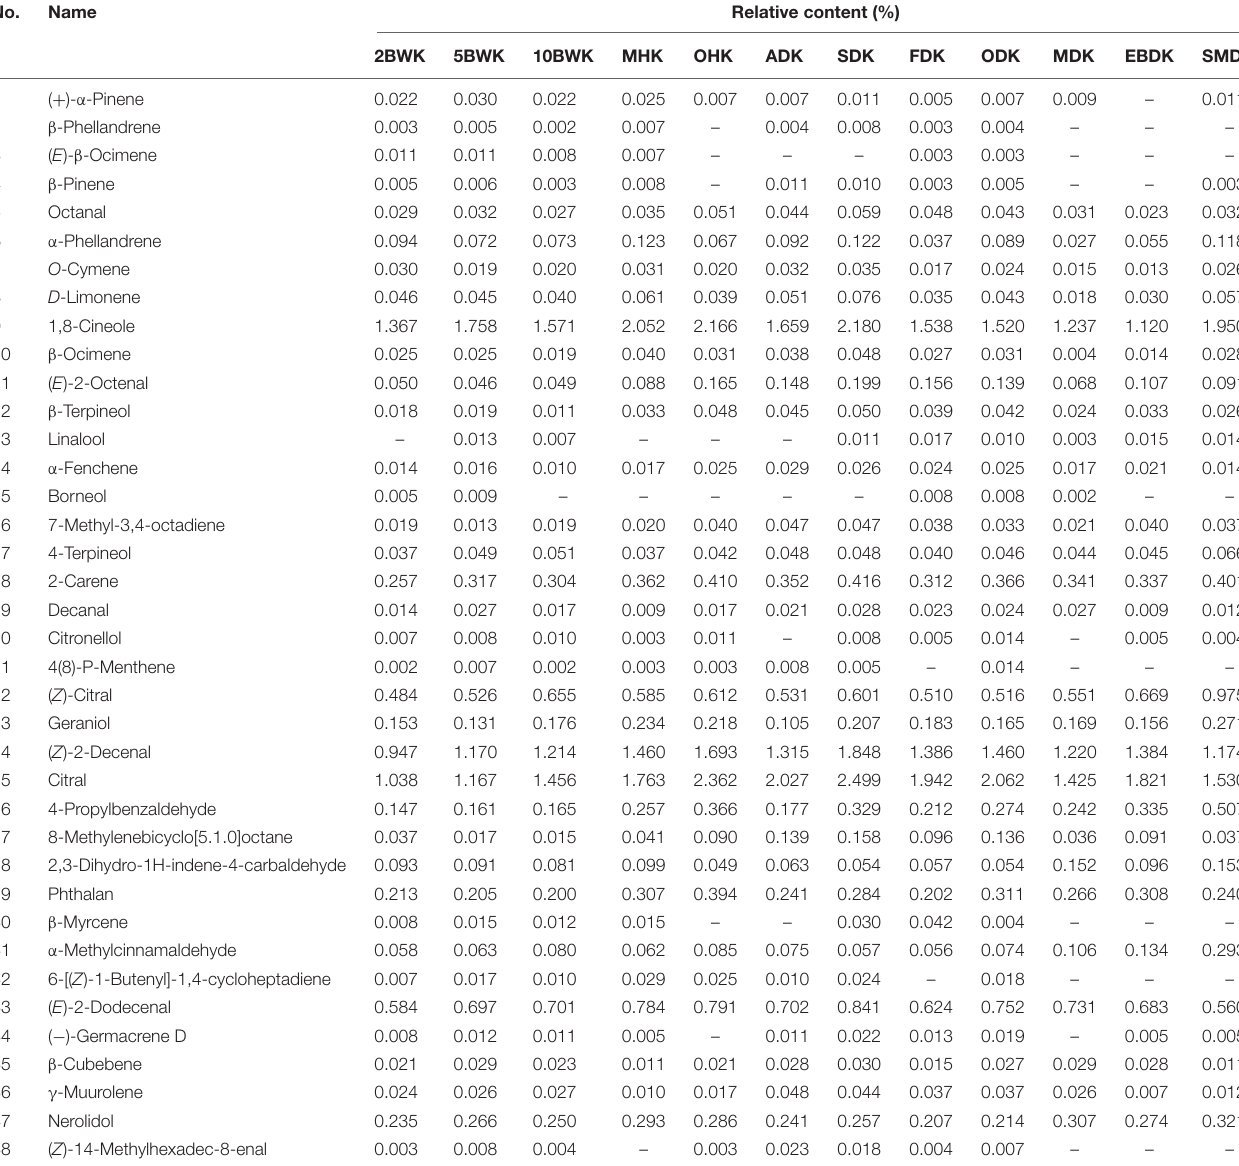
TABLE 2 | Relative content of volatiles in kernel of A. tsao-ko .